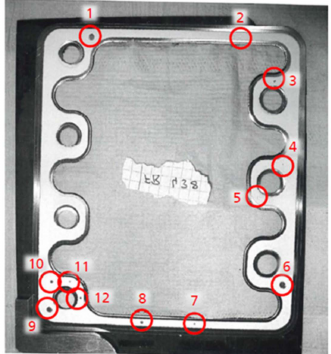
Figure 11. The sample preparation with artificial defects (voids) in the glass solder before joining. From [3], with